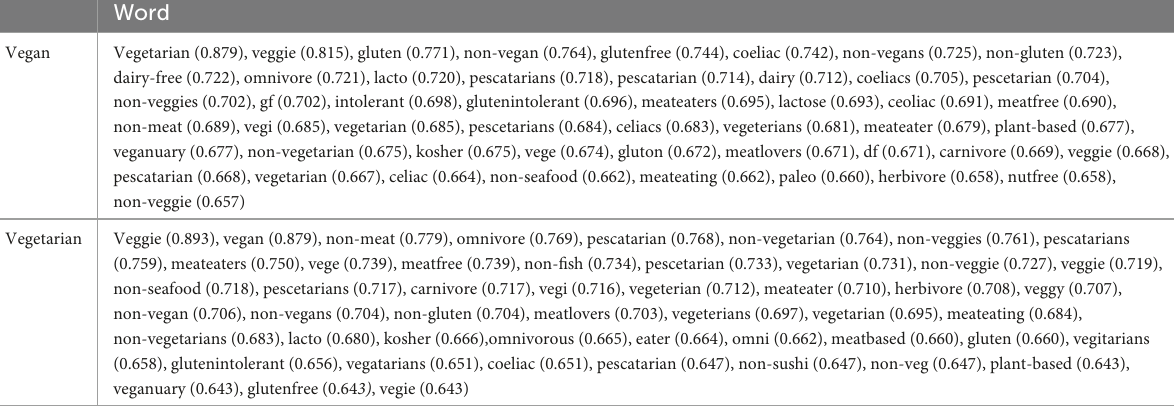
TABLE 1 Top 50 words with high cosine similarity to vegan and vegetarian.